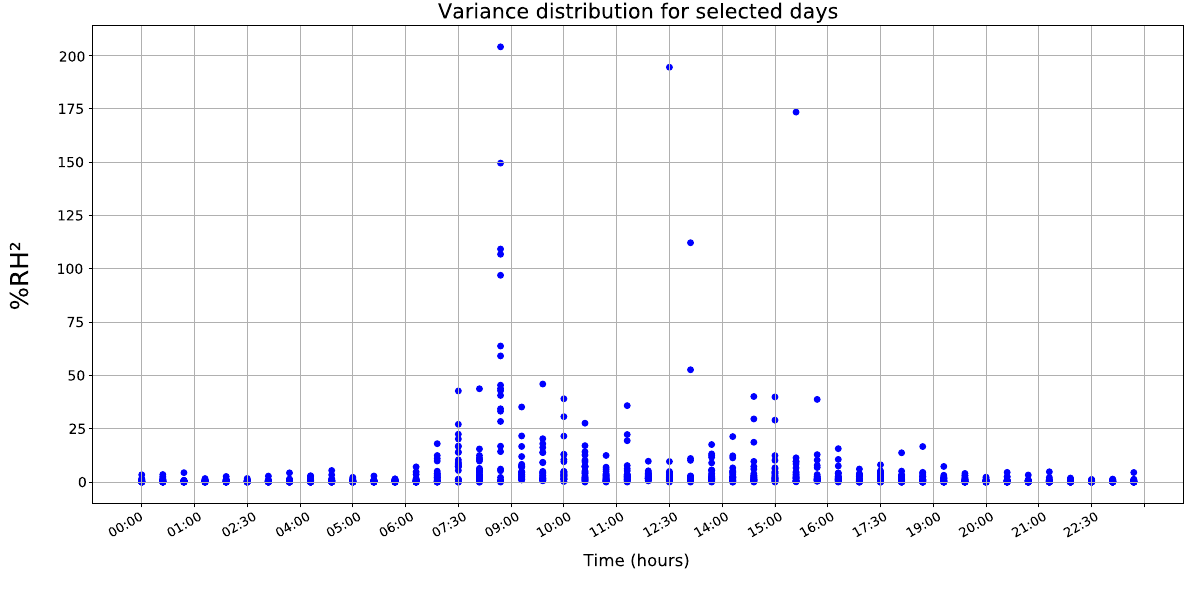
Figure 15. Variance behavior for all